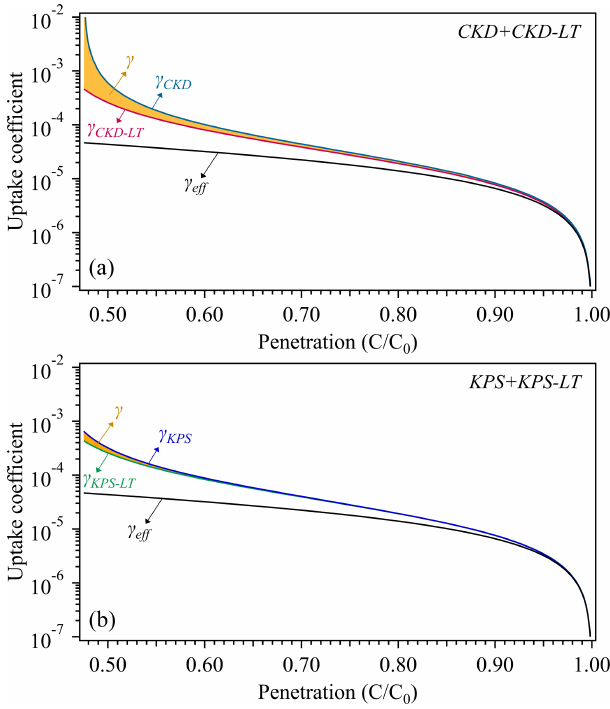
Figure 9. Schematic of different types of uptake coefficients ver- sus the measured penetration ( C /C 0 ), using both diffusion cor- rection methods CKD (a) and KPS (b) as well as their modified versions, i.e., CKD-LT and KPS-LT, to evaluate roughness-induced local turbulence effects. The yellow shaded area shows the uncer- tainty range of γ . Derivation of the uptake coefficient is based on the following assumptions: gas reactant, O 3 ; carrier gas, N 2 ; volumetric flow rate F = 5Lmin − 1 at 1atm and 298K; flow tube dimension, d = 22mm, L = 250mm. δ g and δ r of the coating material are de- fined by δ g /R 0 = 0 . 2, δ r /δ g = 0.5. The choice of 0.5 for δ r /δ g represents an extreme rough coating